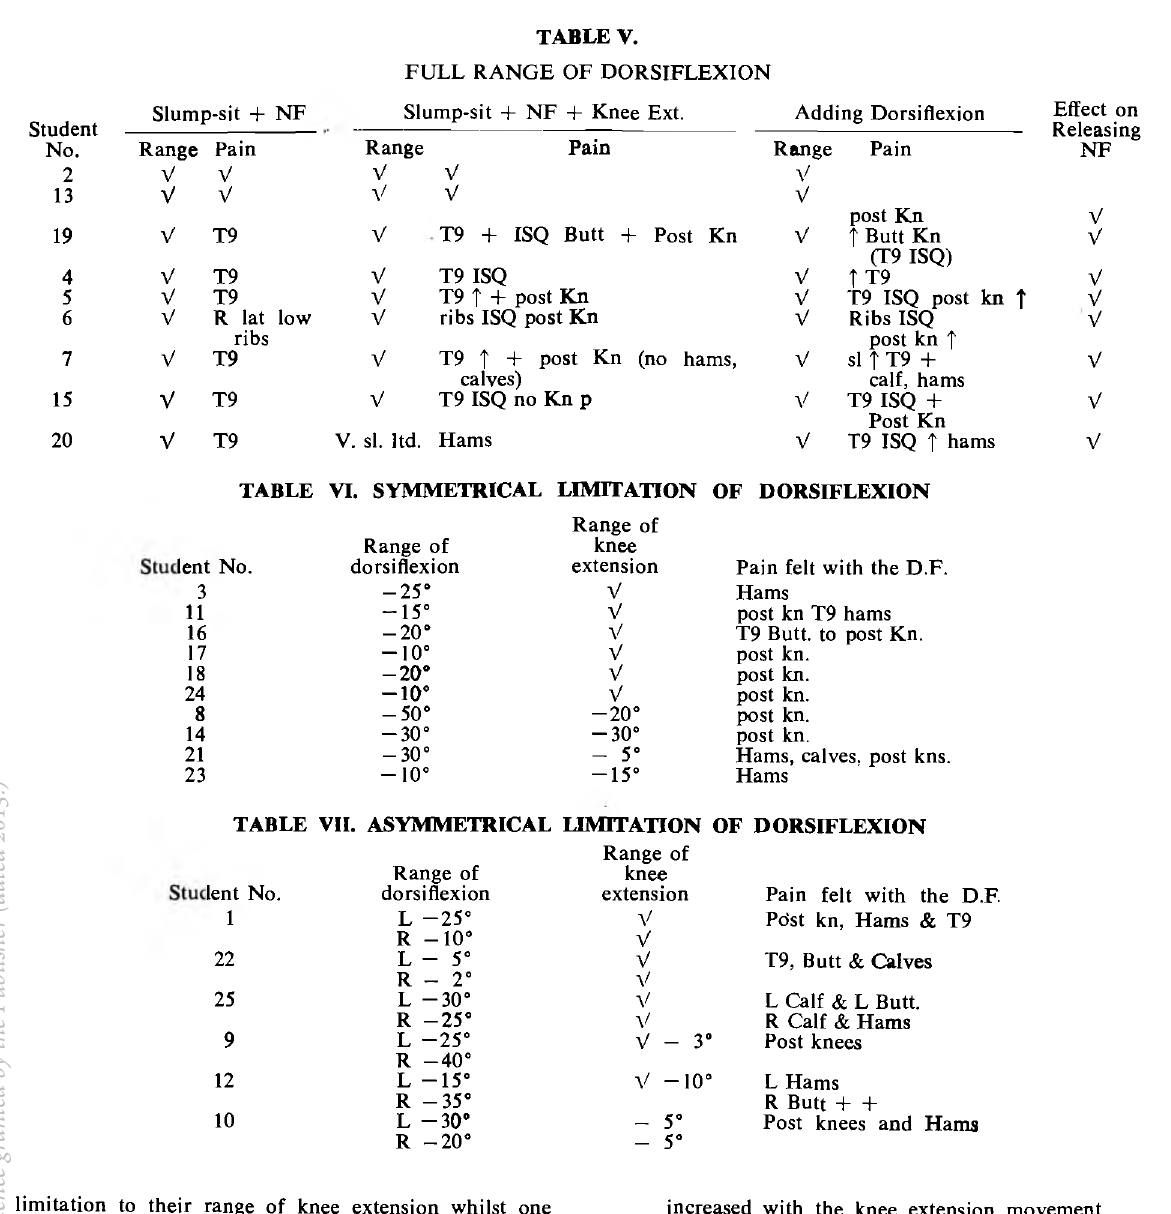
TABLE VII. ASYMMETRICAL LIMITATION OF DORSIFLEXION Range of Range